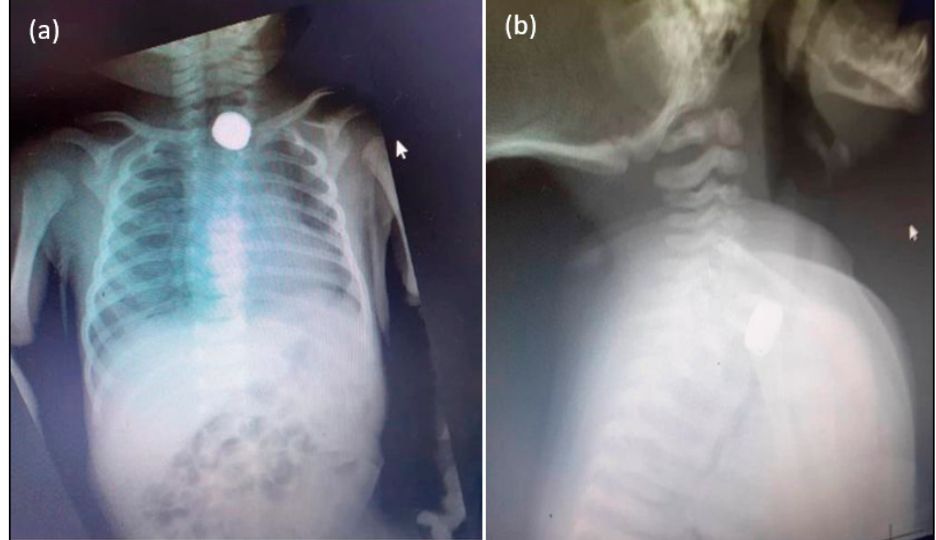
Figure 1. Posteroanterior ( a ) and lateral X-ray ( b ) views show metallic circular FB (battery) in the upper oesophagus.